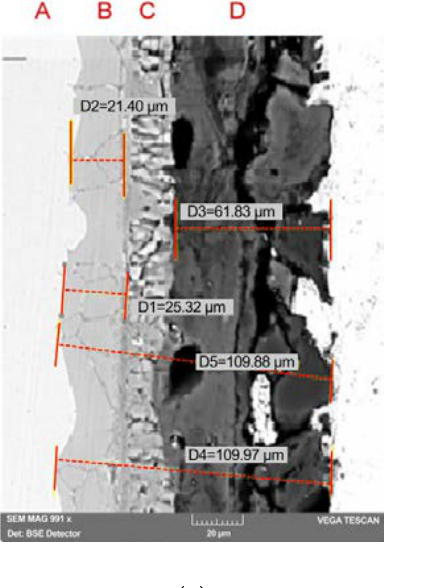
Figure 5. The distribution of the elements on the surface of 316L stainless steel samples treated by PEO: ( a ) S1 sample; ( b ) S2 sample. Table 3. Elemental content (EDS analysis) of samples.